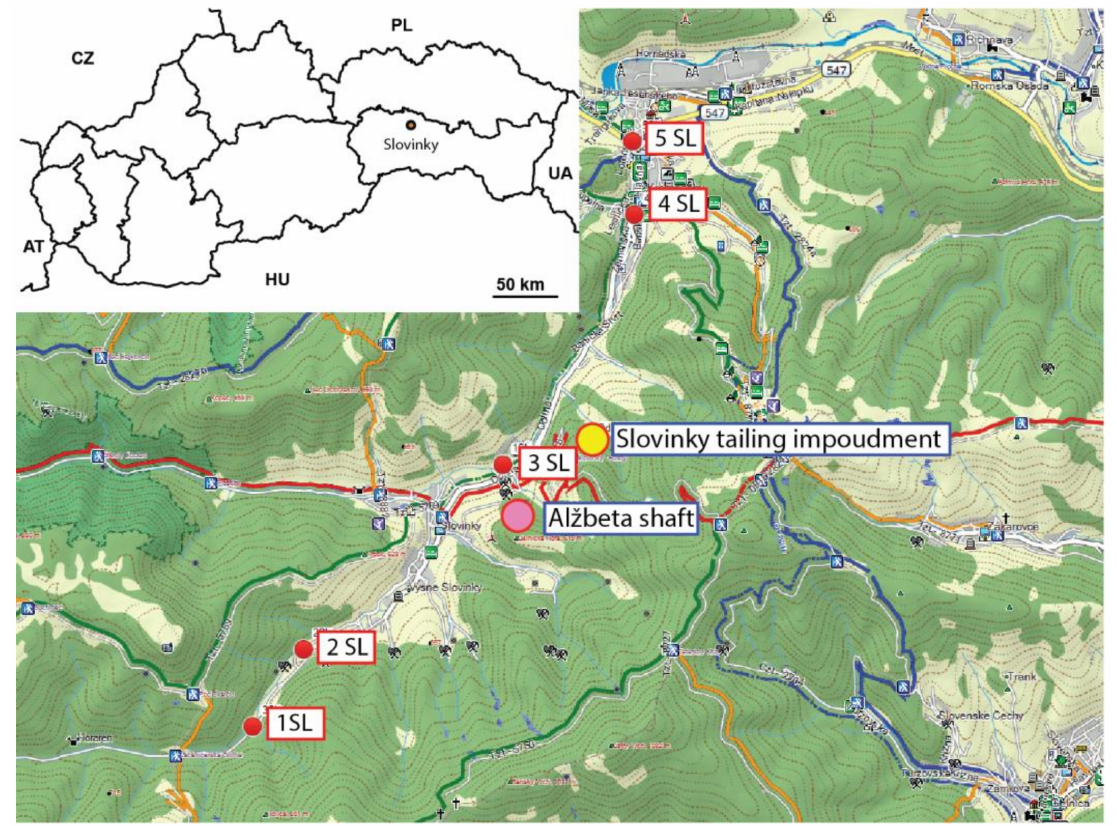
Figure 1. Locations of the research sites in the investigated area of the Slovinsk ý creek